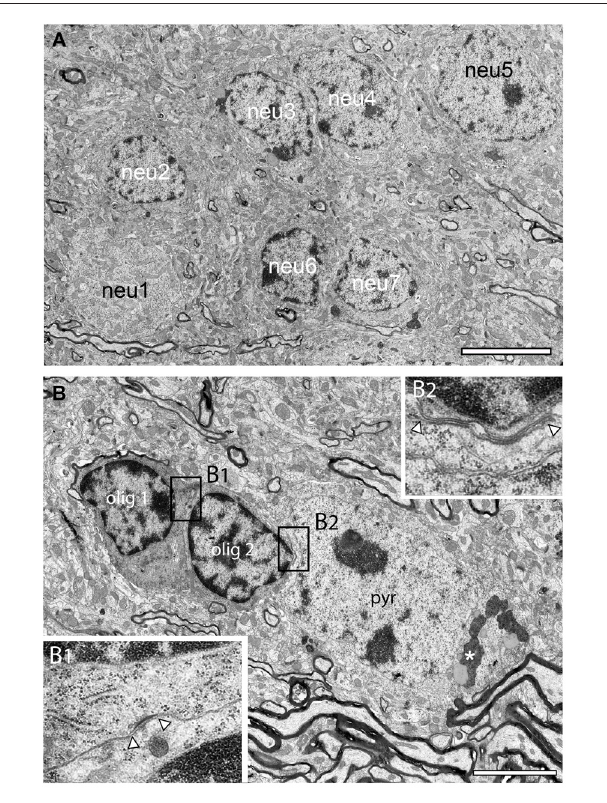
FIGURE 7 | Neuronal clusters in the adult reeler mouse neocortical mass. (A) Large homologous cluster of seven, putative spiny stellate neurons (neu1–neu7) in the mid part of the neocortical mass as indicated by their comparably smaller size and distribution of the heterochromatin. (B) Typical example of a heterologous cluster between two oligodendrocytes (olig1, olig2) and a putative pyramidal neuron (pyr) located close to a massive axonal fiber bundle. The framed areas (B1,B2) show a tight-junction (B1) between the two oligodendrocytes and a gap-junction between olig 2 and the adjacent pyramidal (pyr) neuron (B2) . Note the appearance of lipofuscin granula (asterisk) in the cytoplasm of the pyramidal neuron but not in the oligodendrocytes. Scale bar 5 µ